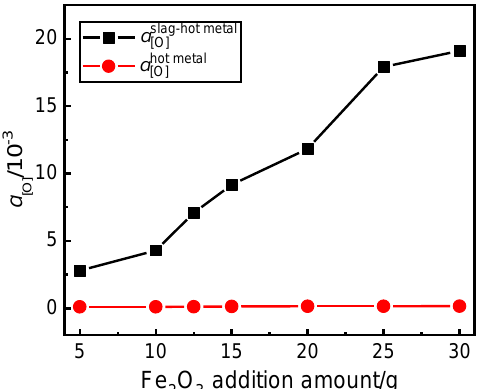
Figure 12. Changes in oxygen activity at the slag–hot metal interface and in the hot metal with the Fe 2 O 3 addition